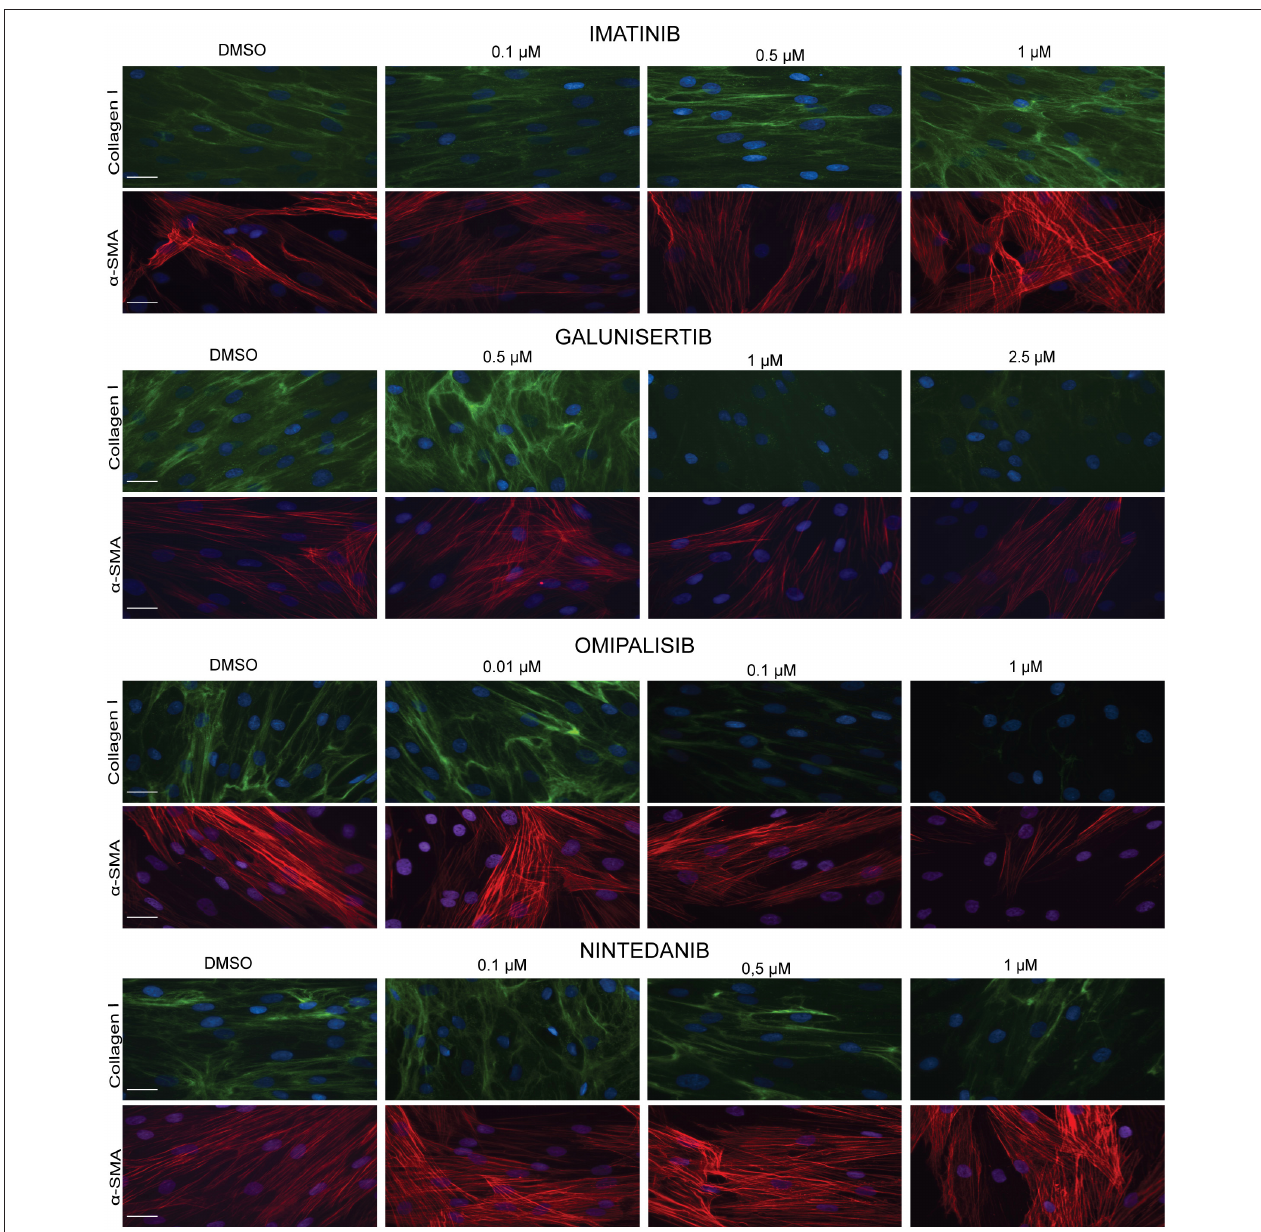
FIGURE 8 | Effect of antifibrotic compounds in dermal myofibroblasts ( n = 2). Immunofluorescence staining of collagen I and α - smooth muscle actin in human dermal fibroblasts after 96h in the presence of TGF β 1 cultured with macromolecular crowder PVP40 and treated with anti-fibrotic compounds Imitanib, Galunisertib, Omipalisib, and Nintedanib. Showing 1 FVO; DAPI, collagen I, α -SMA; magnification 40x; scale bars 200 µ